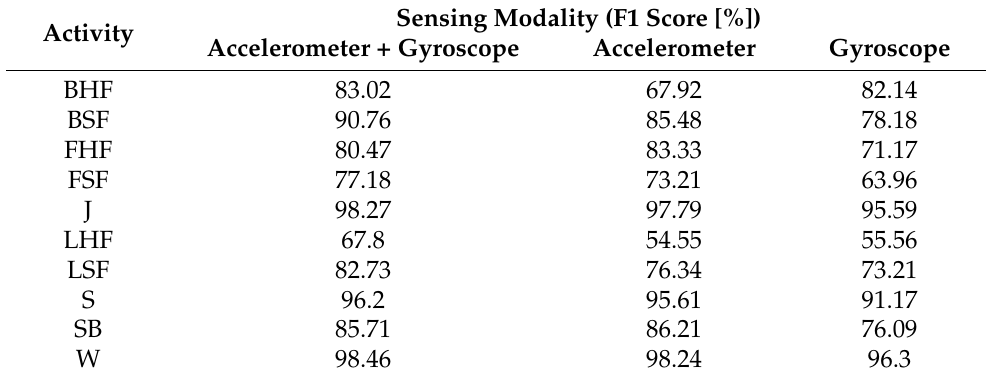
Table 4. Performance for different sensing modalities.